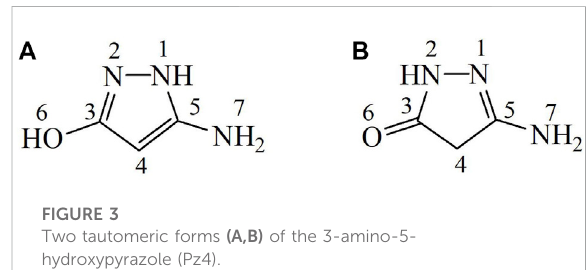
Figure 1. The pyrazole of formula N-(benzyloxycarbonyl)-1H- pyrazole-1-carboxamidine (Pz3) achieved the best results among other studied compounds at a concentration of 10 − 5 mol/dm 3 when it inhibited the growth of Klebsiella – Enterobacter at a level of 82.8%. This pyrazole showed good results (72.8%) even with a lower concentration of 10 − 3 mol/dm 3 . On the other hand, dilution of the Pz2 solution had a major effect on the inhibition of Klebsiella – Enterobacter spp. A solution of pyrazole Pz2 of concentration 10 − 3 mol/dm 3 gave fairly good results with a percentage of inhibition of 75.6%, while a solution of concentration of 10 − 5 mol/dm 3 did not show inhibitory activity for these bacteria. Among the series, the [Cu(Pz3) 2 (MeOH) 2 ] (CuPz3) compound (10 − 5 mol/dm 3 ) was found to be the most active (73.1%) against E. coli compared with standard amoxicillin, whereas the same compound did not show any antibacterial activity for Klebsiella – Enterobacter spp. [C U (Pz5) (H 2 O) 2 (MEOH) 2 ] 2 (CuPz5 I ) and [Cu(Pz5) 2 (MeOH) 2 ](CuPz5 II ) did not show an inhibitory effect on the tested bacteria. The average percentage of inhibition achieved by testing Cu(II) complexes used in comparison to control is presented in Figure 2.